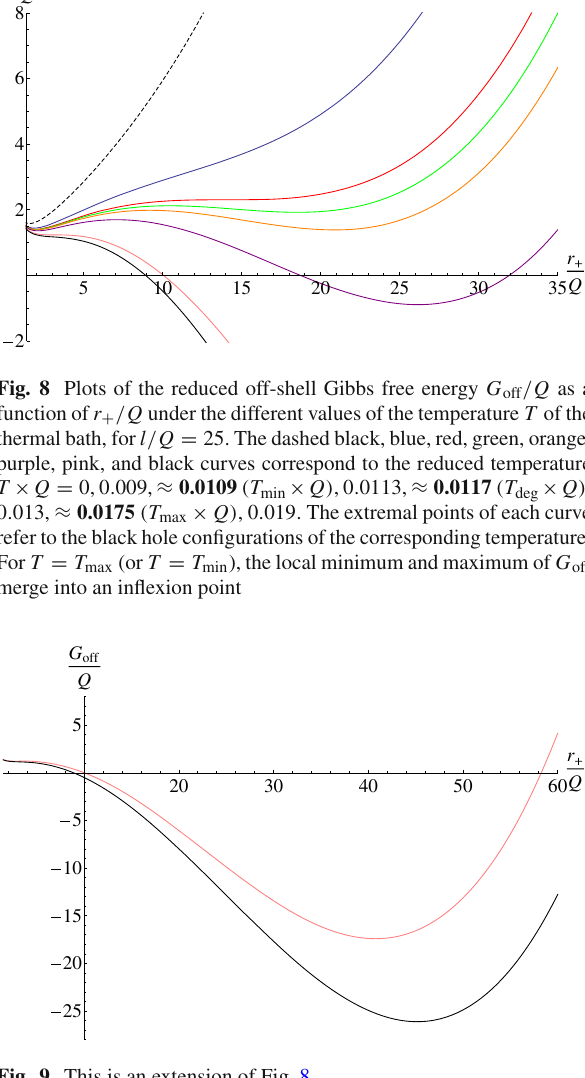
Fig. 9 This is an extension of Fig.